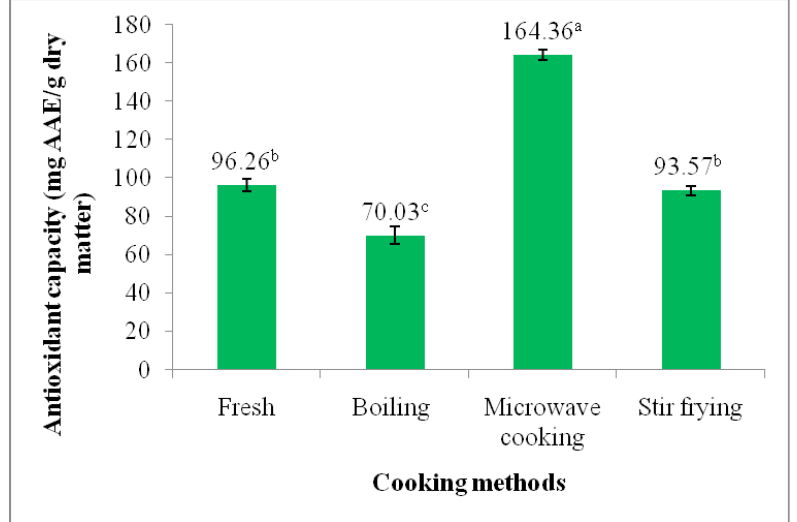
Figure 3: Antioxidant capacity of fresh and cooked tomato. Data are presented as mean ± standard error. Mean values with different superscripts are significantly different at p< 0.05 by analysis of variance followed by Duncan’s multiple range test.